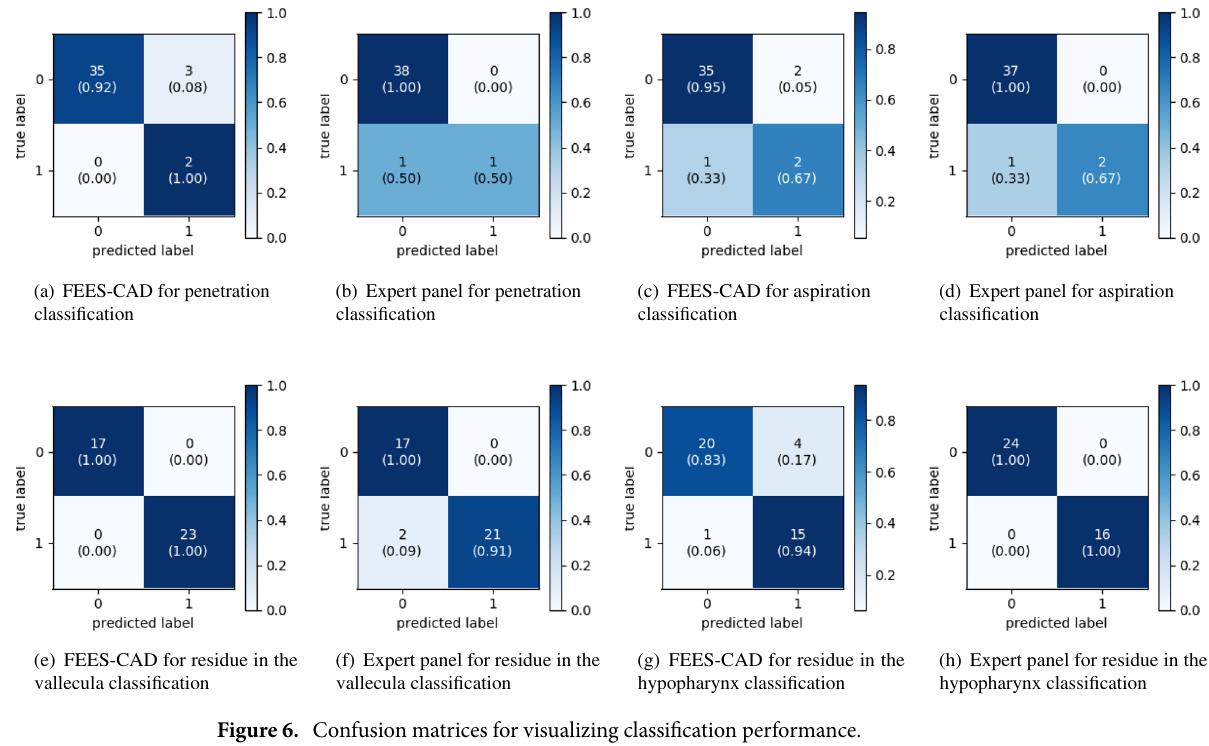
Figure 6. Confusion matrices for visualizing classification performance.